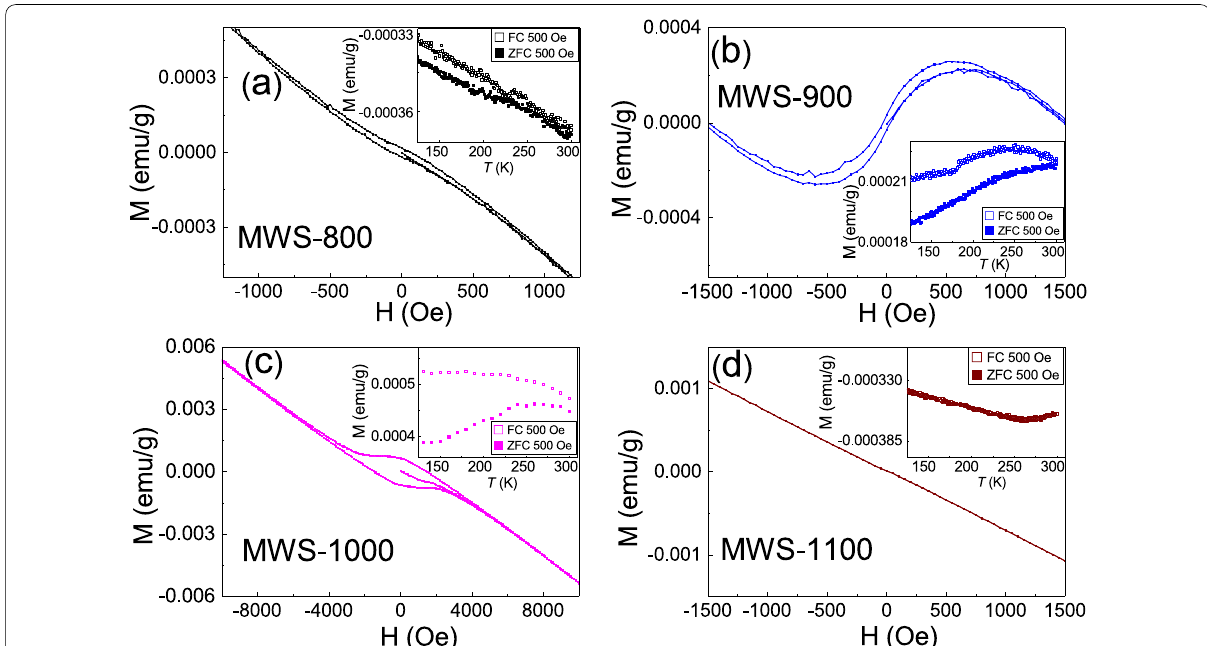
Fig. 3 The magnetic field‑dependent magnetization. Figure ( a – c ) reveals hysteresis loops. Figure d shows diamagnetism feature and no hysteresis loops. The inset shows the magnetization of field cool and zero field cool processes. The field cool and zero field cool curve split in all of the samples except for the